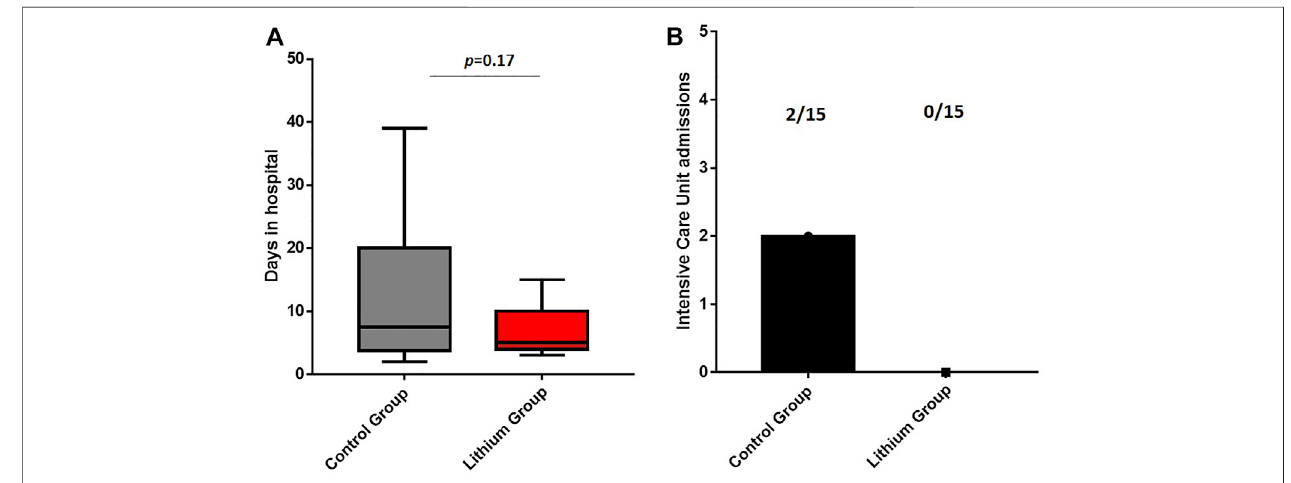
FIGURE1|(A) Days ofhospital admission. The lithium treatment group has alower number ofdays ofhospital admission. (B) IntensiveCareUnit admissions. The control group had two intensive care unit admissions while the lithium group had no intensive care unit admissions.